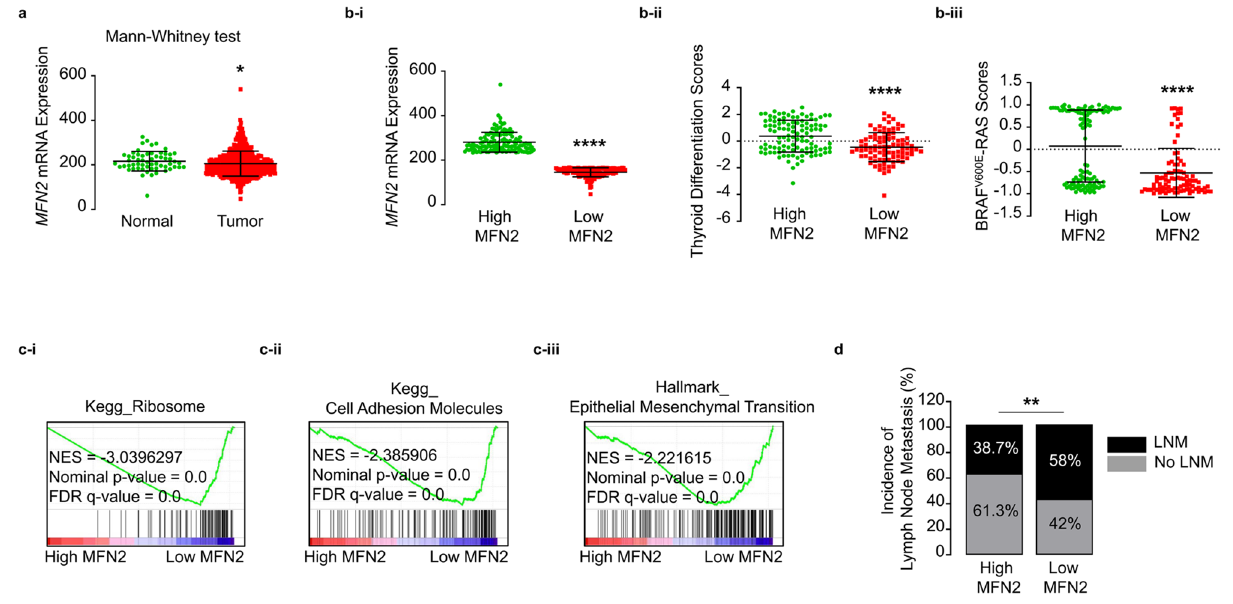
Figure 1. MFN2 expression is a prognostic marker in human thyroid cancer. ( a ) Comparison of the mRNA expression of MFN2 between normal thyroid tissue (n = 59) and tumors (n = 505). ( b ) Comparison of MFN2 expression ( i ), thyroid differentiation scores ( ii ), and BRAFV600E-RAS scores ( iii ) between high and low MFN2 tumor groups (n = 126 for both). ( c ) Tumor invasion-associated gene sets enriched in the low MFN2 tumor group compared to those enriched in the high MFN2 group (n = 126 for both). ( d ) Comparison of the incidence of cervical lymph node metastasis between the high and low MFN2 tumor groups (n = 126 for both). (A-D) TCGA-THCA data analyses. Data represent the mean ± SD. Asterisks (p < 0.05 [*], p < 0.01 [**], p < 0.0001 [****]) indicate significant differences from the statistical analyses. THCA thyroid